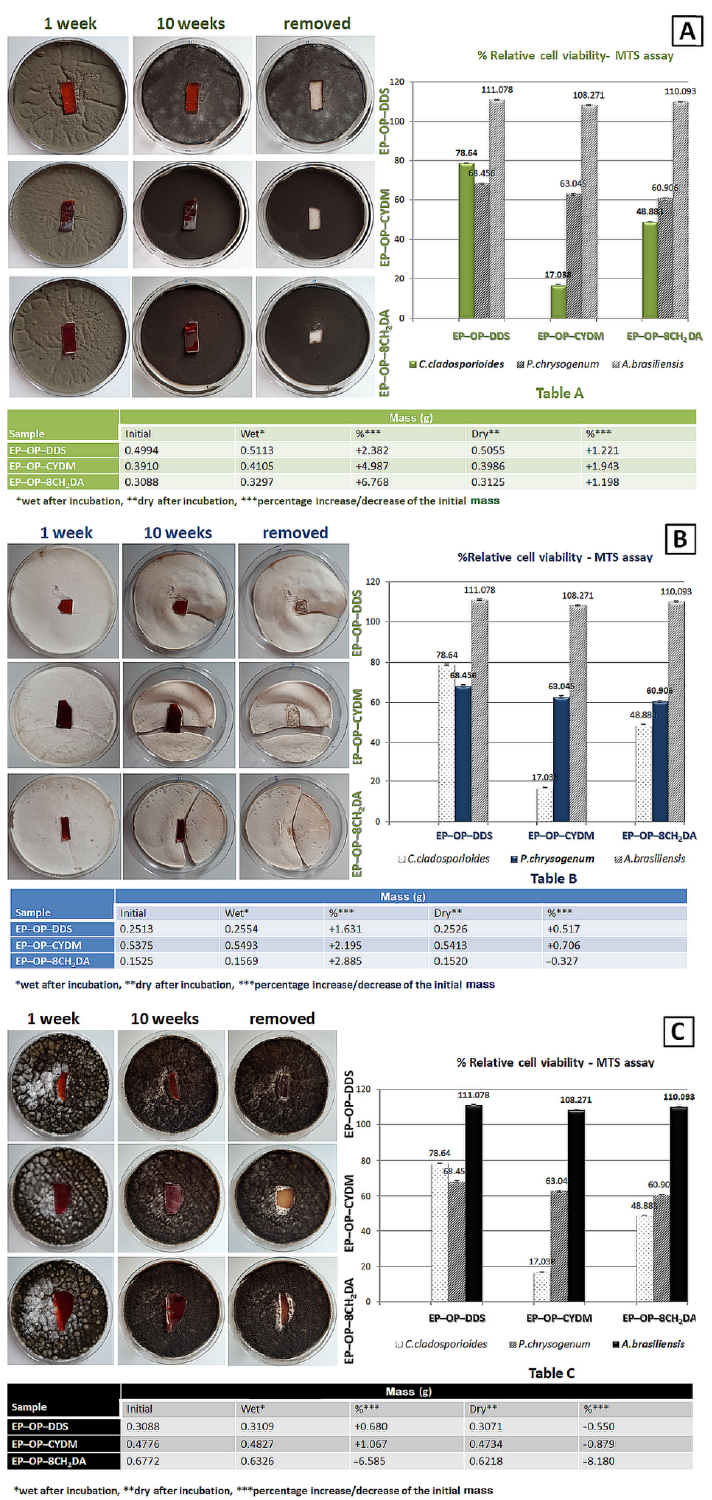
Figure 12. ( A ) S–IPNs exposed to the action of C. cladosporioides for 1 week, 10 weeks and removed afterwards; fungistatic efficacy and mass variation. ( B ) S–IPNs exposed to the action of P. chrysogenum for 1 week, 10 weeks and removed afterwards; fungistatic efficacy and mass variation. ( C ) S–IPNs exposed to the action of A. brasiliensis for 1 week, 10 weeks and removed afterwards; fungistatic efficacy and mass